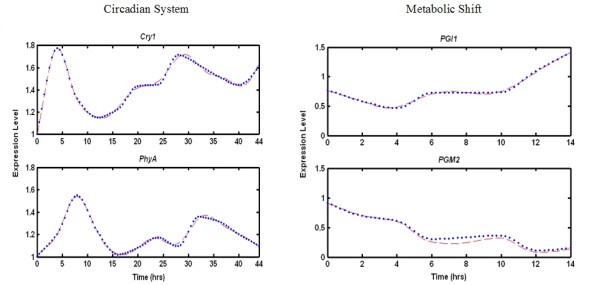
The second-order dynamic model fitting of pathway genes. The expression profile with corresponding second-order dynamic model fitting for Cry1, PhyA (pathway of circadian regulatory system of Arabidopsis thaliana) on the left-hand side, and PGI1, PGM2 (metabolic shift pathway of yeast Saccharomyces cerevisiae) on the right-hand side. The blue dotted points are the cubic spline interpolations of microarray data, and the red dashed lines are the estimated dynamic evolution of expression data.